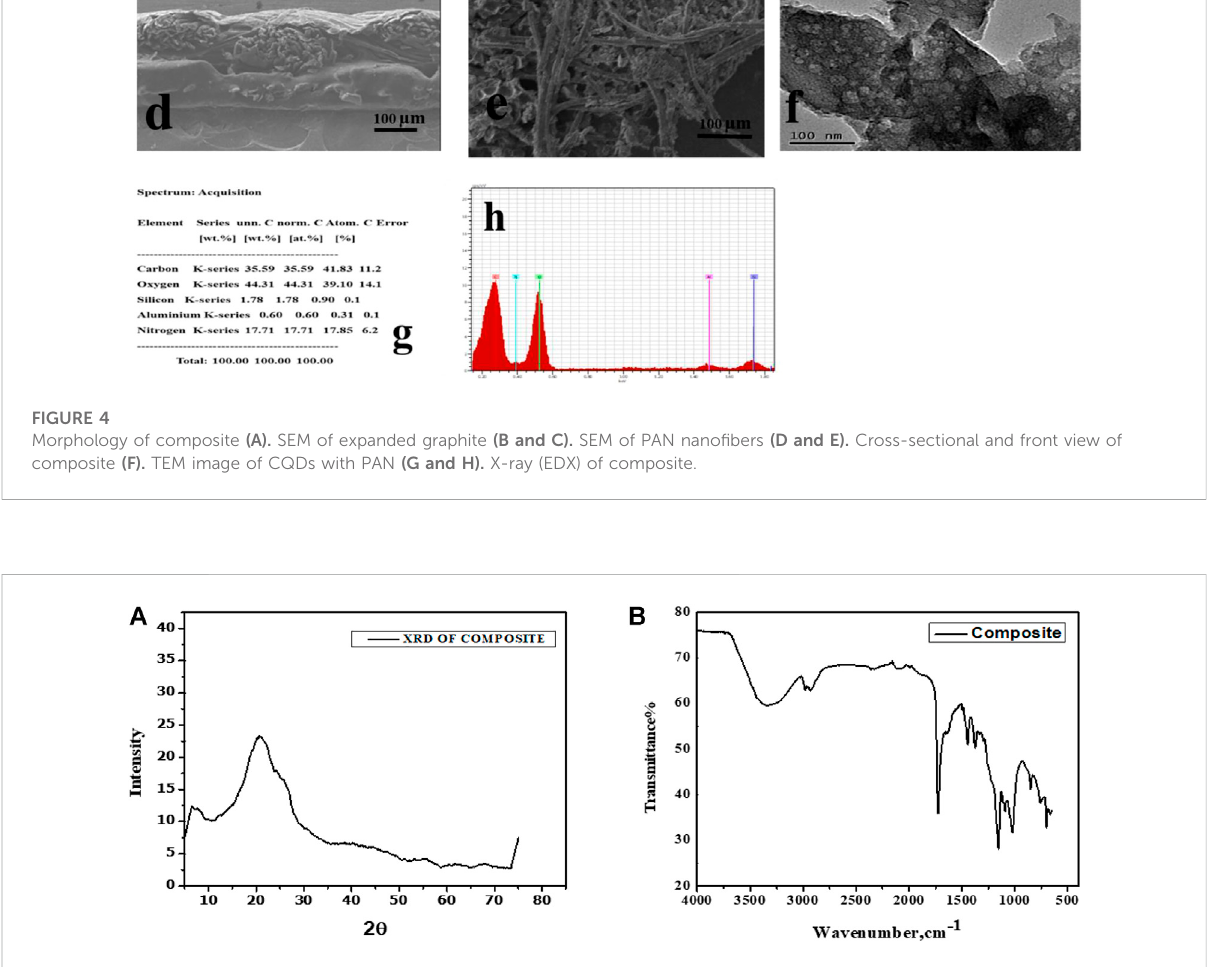
FIGURE 5 (A) XRD of composite. (B) FTIR of